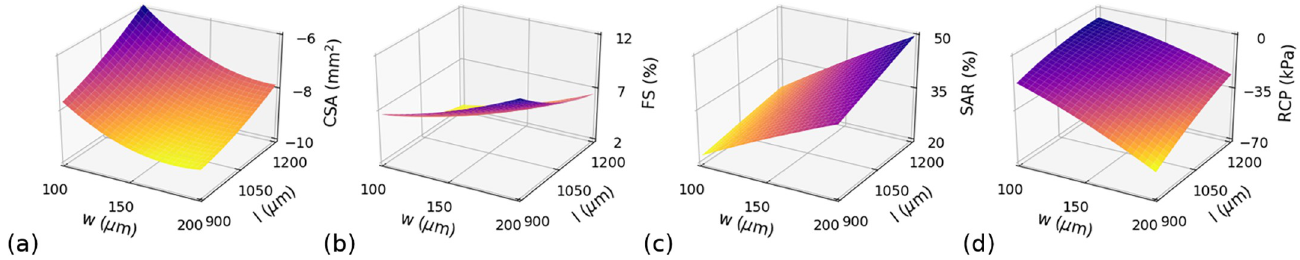
and t constant at r